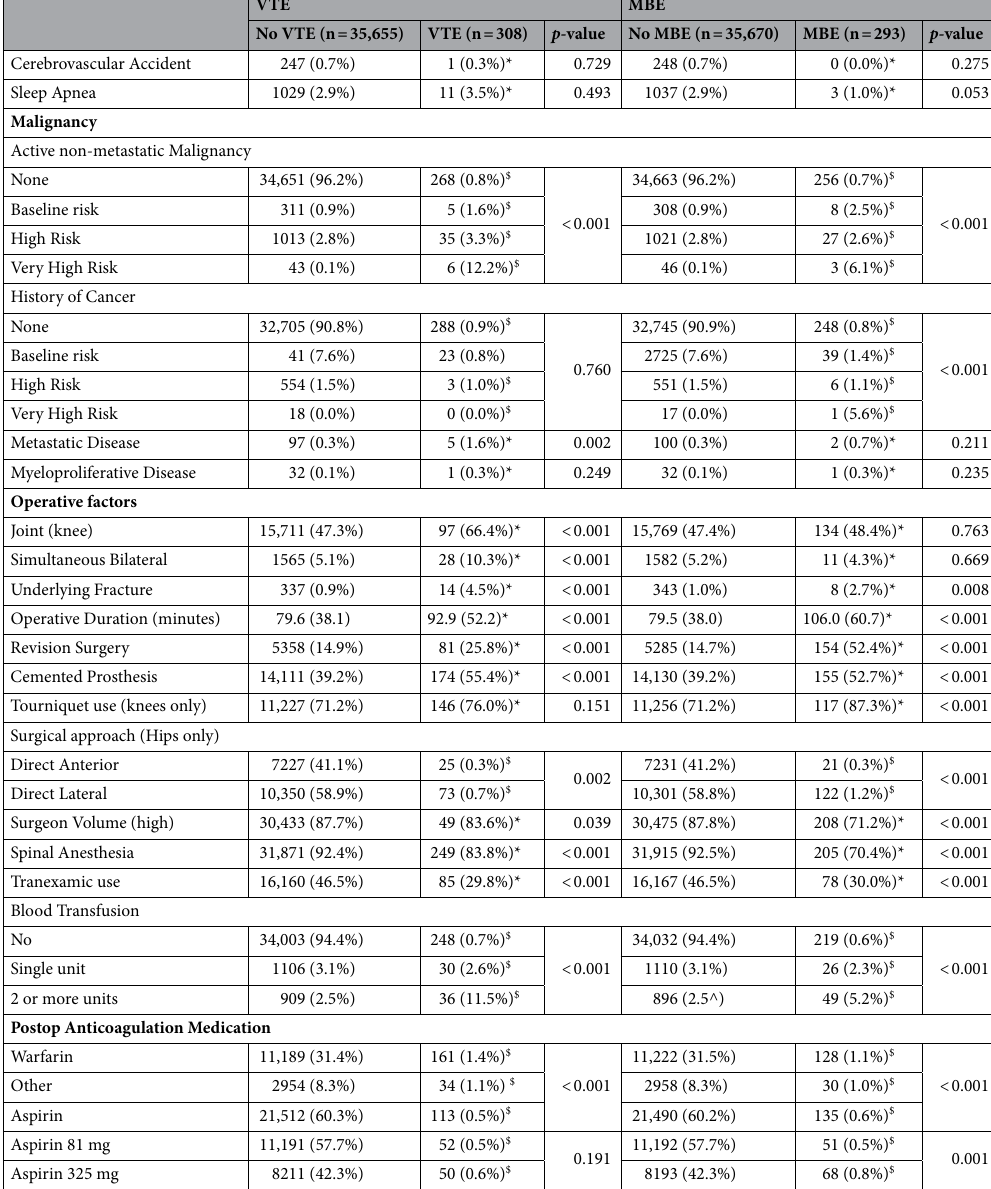
Table 1. Patient demographics, characteristics, operative and anticoagulation medications stratified based on development of venous thromboembolism and major bleeding events. Categorical variables were analyzed with a Chi square test and continuous variables with a Student’s t-test. An alpha of 0.05 was used to evaluate significance. Data presented as number (percentage) or mean (standard deviation). *Percent within VTE/MBE. $ Percent within the tested variable. American Society of Anesthesiologists (ASA); Milligram (mg); Kilogram (kg); Meter (m); Venous thromboembolism (VTE); Major bleeding event